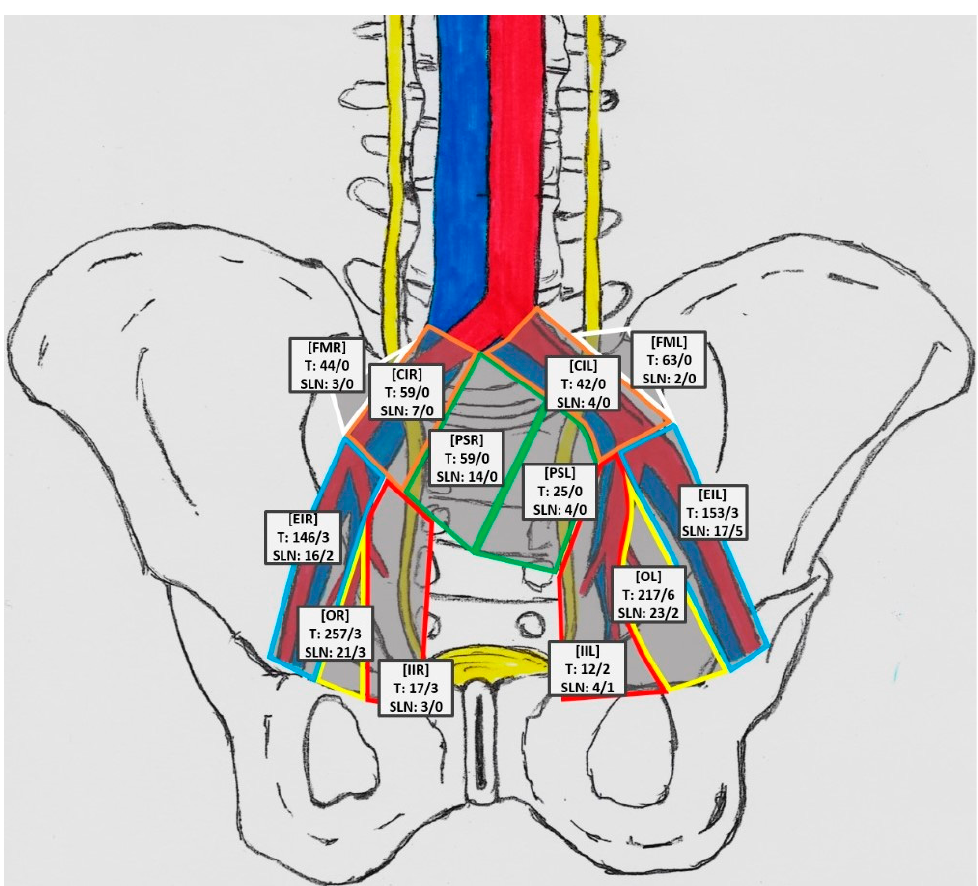
Figure 4. Topography of sentinel nodes in individual anatomical regions, considering the number of LNs removed. Explanation of labels—top line: [region name]; middle line: number of removed LNs/number of LN+; bottom line: number of SLNs/number SLNs+; FMR: Marcille’s fossa right, FML: Marcille’s fossa left, CIL: common iliac left, CIR: common iliac right, PSR: presacral right,